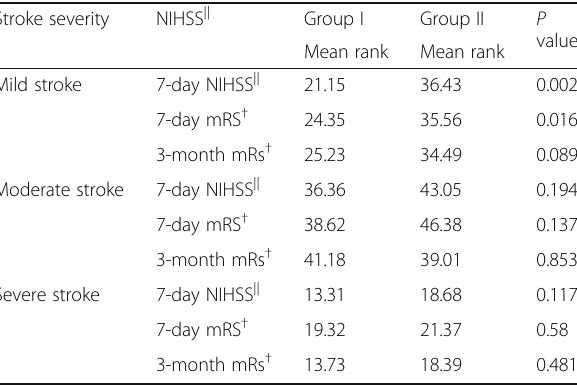
Table 2 Comparisons of 7-day NIHSS, 7-day mRS, and 3-month mRs in both groups ’ subtypes based on NIHSS severity Stroke